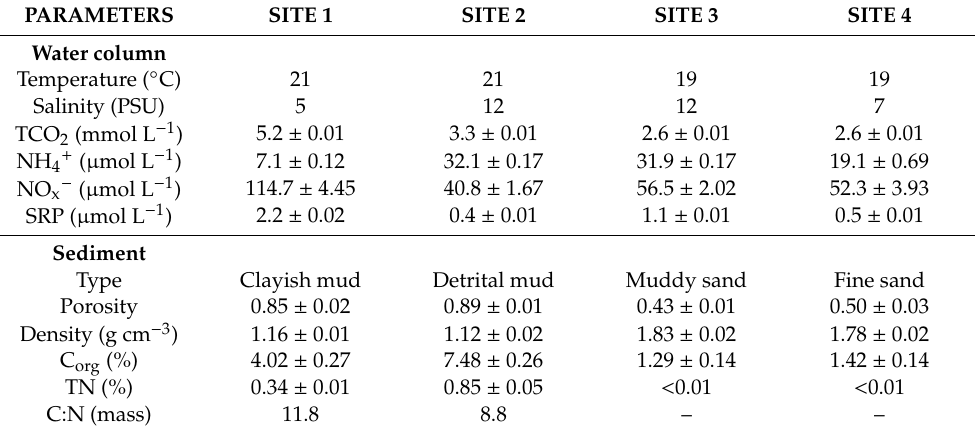
Table 1. Bottom water physico-chemical features and surface sediment (0–5 cm) characteristics at the sampling sites in the Sacca di Goro Lagoon. Averages ± standard error are reported (n =